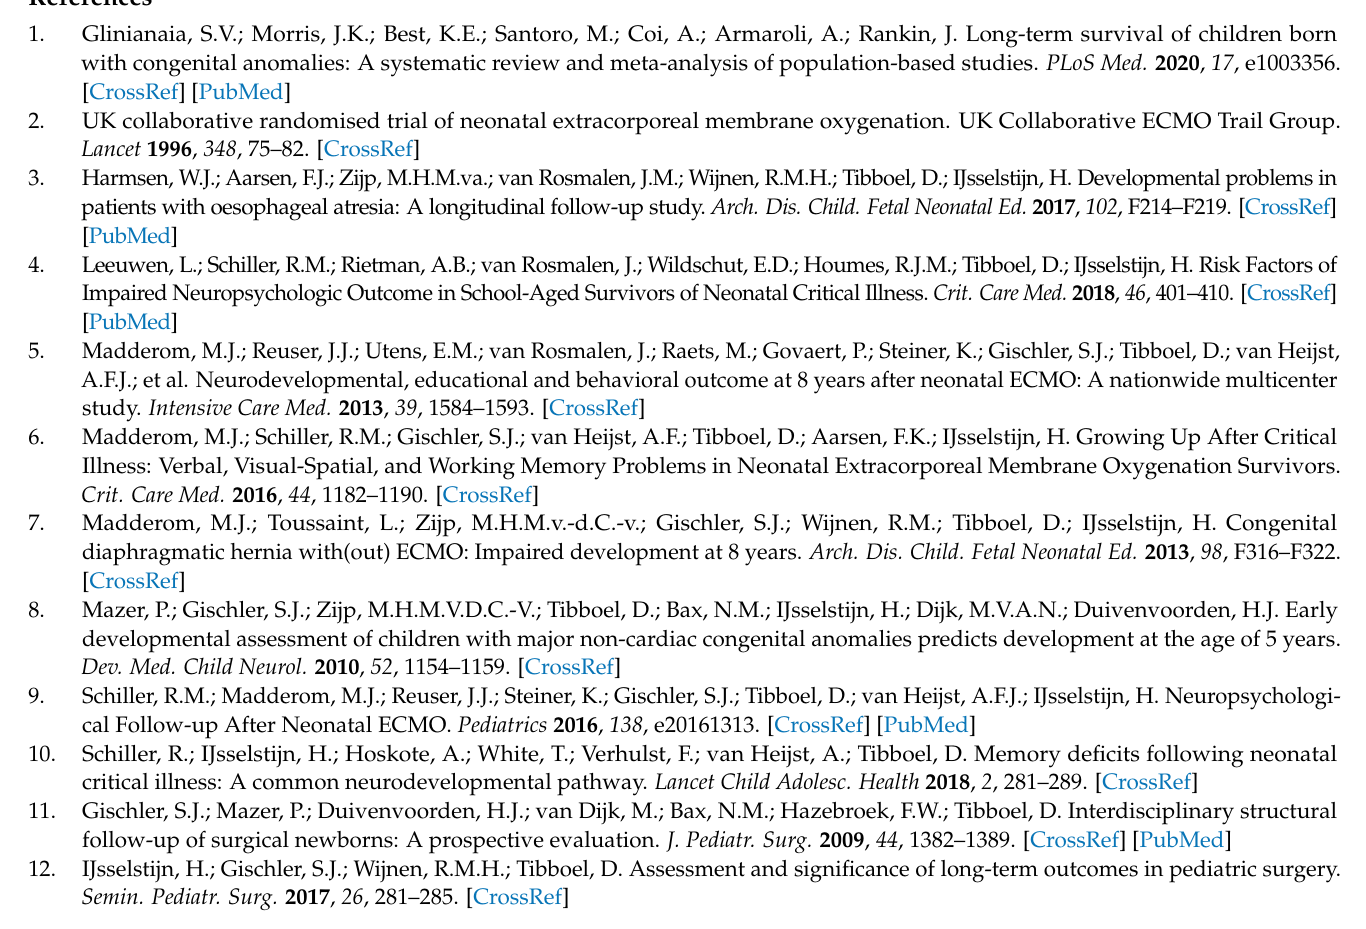
Table S2. Outcomes of neuropsychological assessments in different subgroups; Table S3. Simple regressions per variable for self-reported PedsPCF; Figure S1. Association between 30-item and 10-item PedsPCF; Figure S2. Flowchart triage prior to neuropsychological assessment; Supplementary B. Descriptions of the neuropsychological